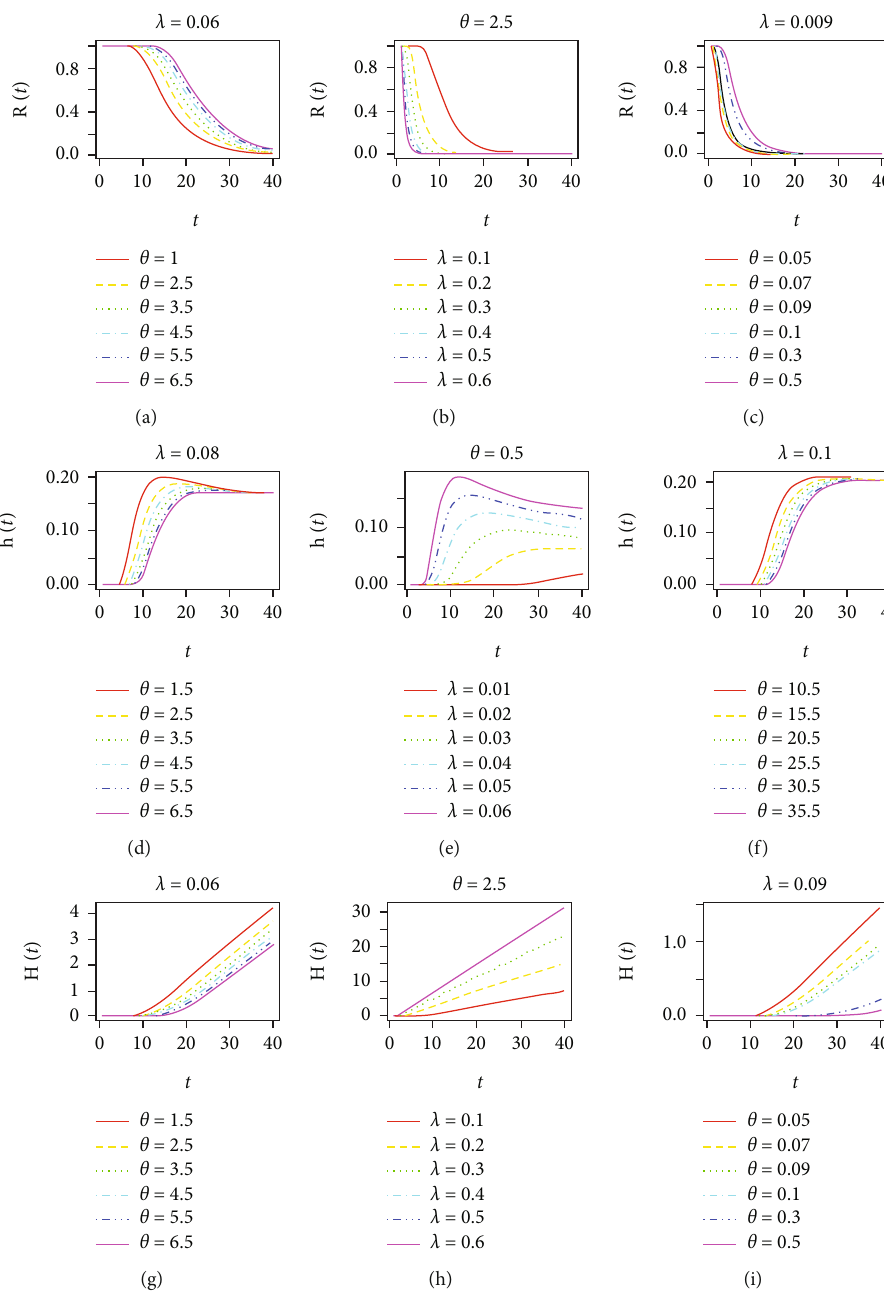
Figure 2: The reliability, hazard, and cumulative hazard function plots of IRE distribution for di ff erent values of